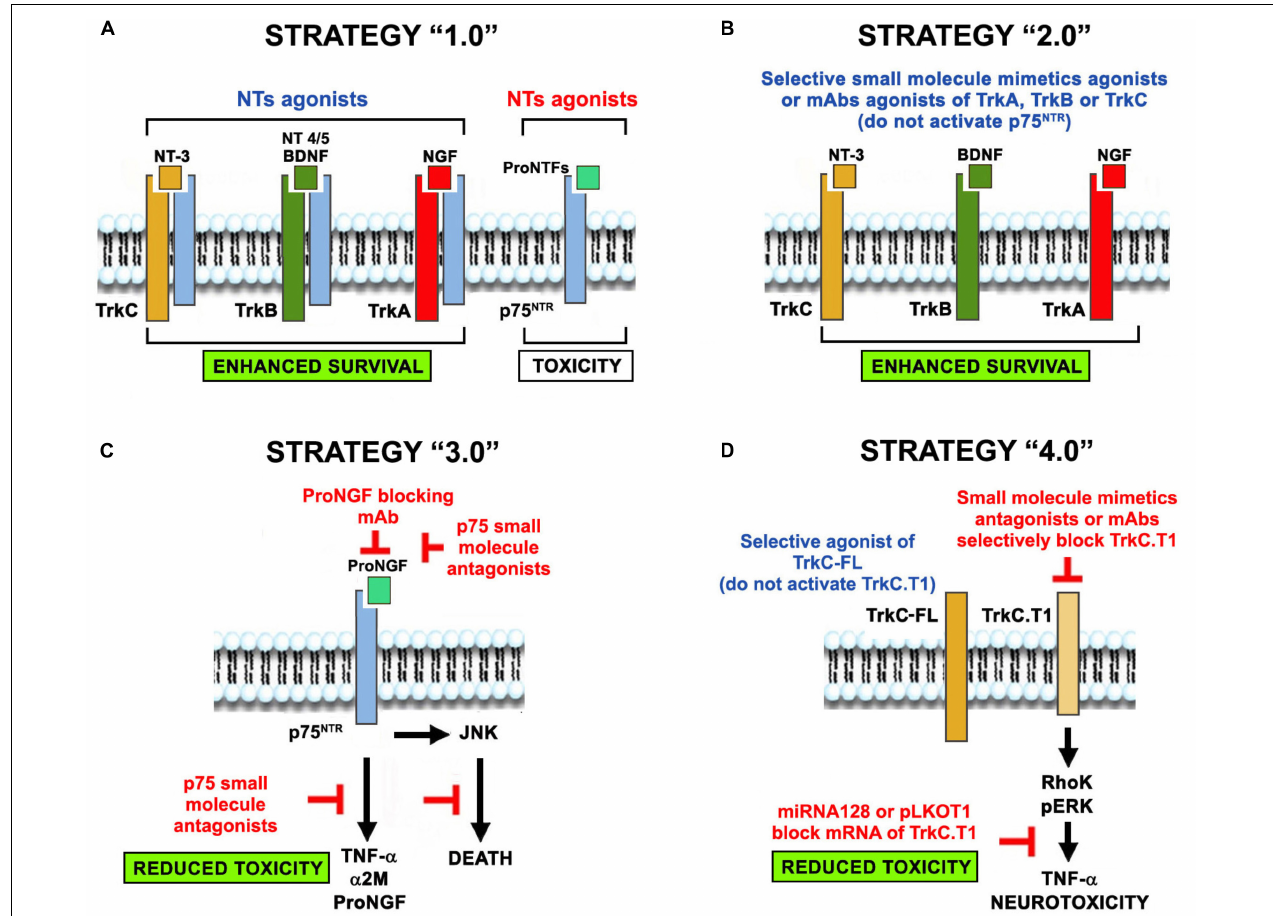
FIGURE 2 | The evolution of the concept of NT-based neuroprotection. Four neuroprotective strategies evolved from the use of NTs-based therapies in neurodegenerative diseases. (A) Neuroprotection strategy 1.0 was the original use of NTs regardless of receptor selectivity, causing unintended signaling through p75 NTR or truncated Trk isoforms that are up-regulated in neurodegenerative pathologies. (B) Neuroprotection strategy 2.0 overcomes some of the drawbacks by using selective agonists of Trk receptors (small molecules, mAbs, and mutant NTs that do not bind p75), circumventing p75 NTR activation. (C) Neuroprotection strategy 3.0 addresses p75 NTR neurotoxicity using selective blocking antibodies and small molecules antagonists. (D) Neuroprotection strategy 4.0 addresses the toxic function of truncated Trk isoforms by using selective Trk full-length agonists (that do not activate the truncated forms) or selective antagonists of